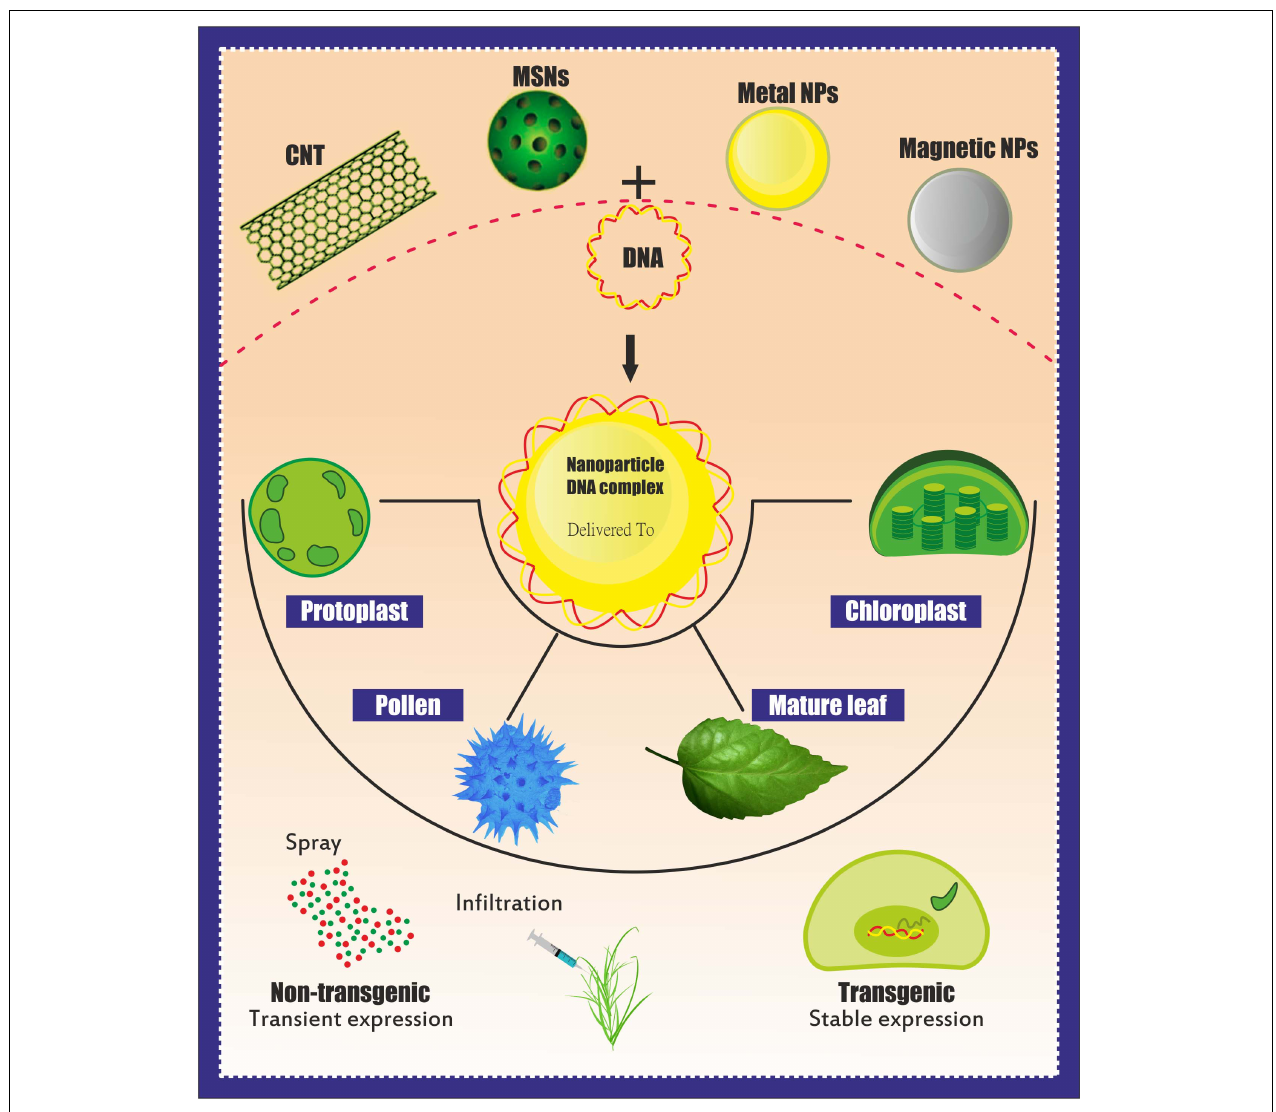
FIGURE 2 | Different-shaped nanoparticles (NPs) for use as genetic cargo for genome editing. The shape and size can be engineered to bind specific biomolecules to produce the most stable bioconjugate complex. NPs can also be used in force-free delivery, i.e., using magnetic properties and electric field usage for penetration (Jat et al.,